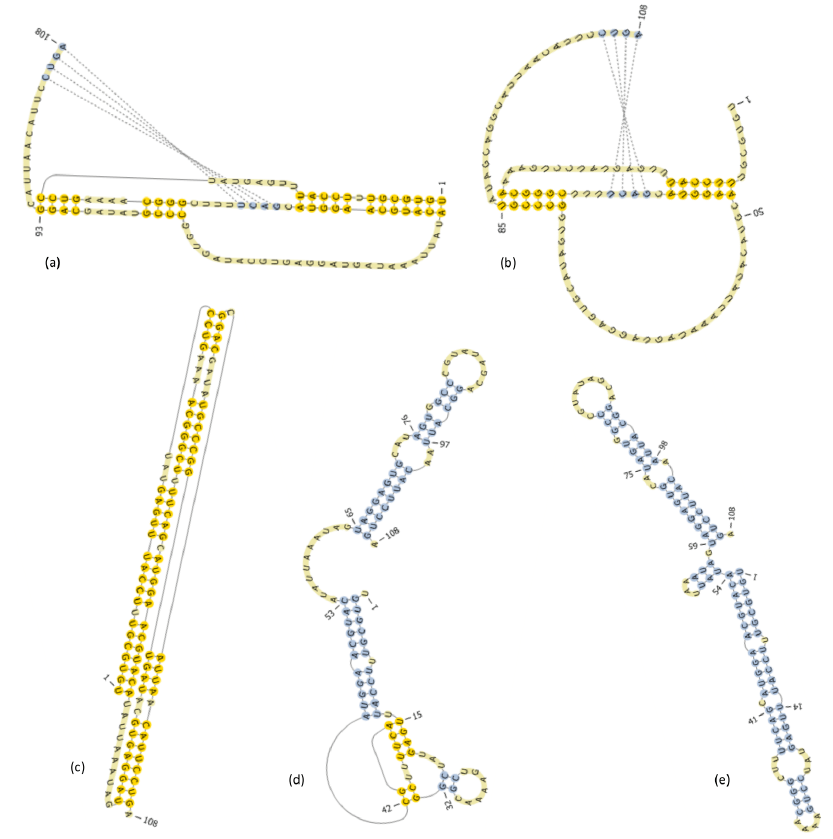
Figure 3. Ground truth ( a ), our platform’s prediction ( b ), Knotty’s prediction ( c ), IPknot’s predic- tion ( d ), and ProbKnot’s prediction ( e ) of L-type pseudoknot presented in